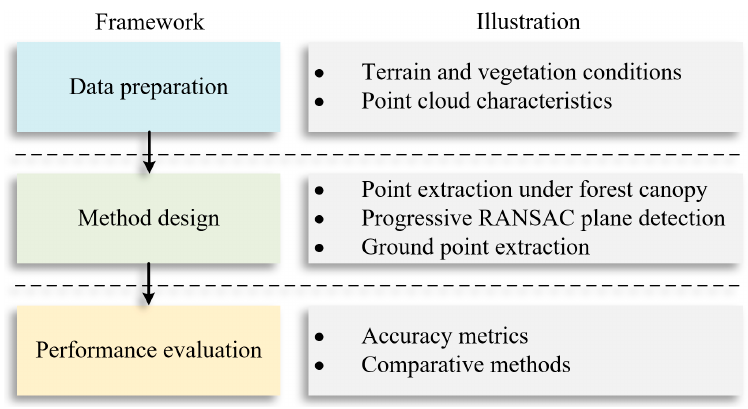
Figure 1. Research framework.